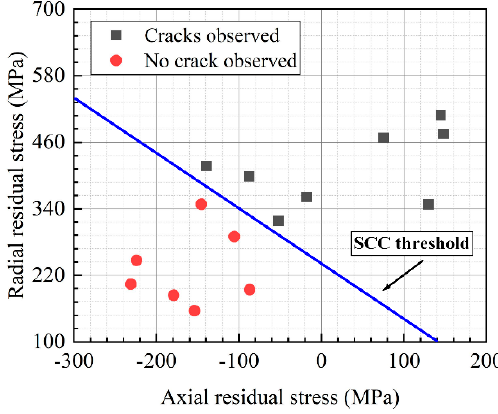
Figure 11. Relationship between SCC initiation and biaxial residual stresses.